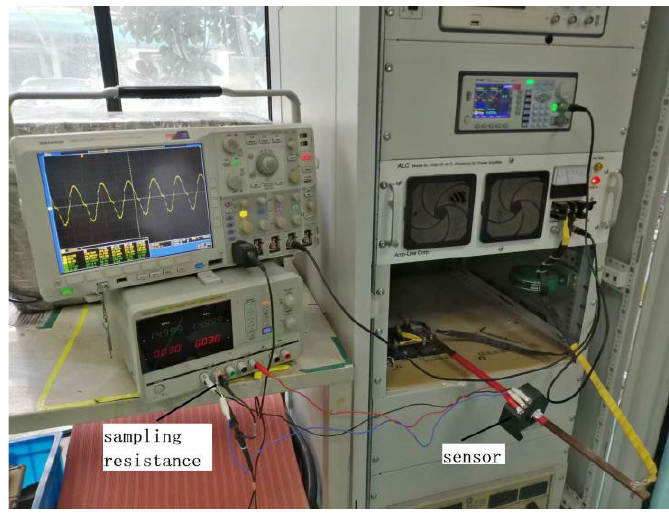
Figure 8. Experimental device.